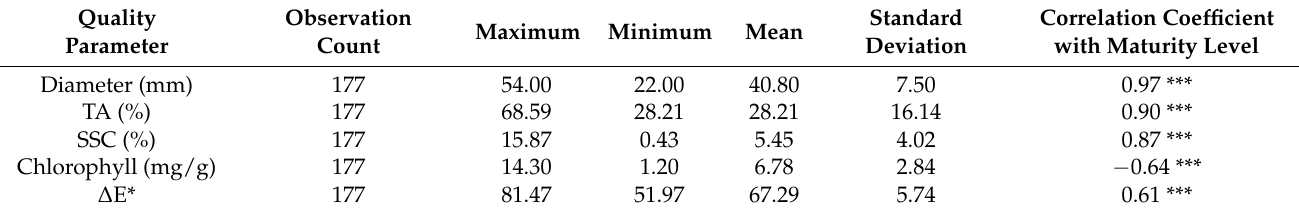
Table 1. Descriptive statistics of some quality